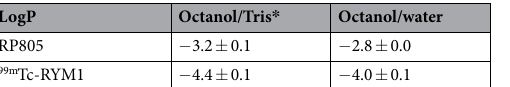
Table 2. LogP values of 99m Tc-RYM1 and RP805. The data represent the mean ± SD of 2 independent experiments, each performed with triplicate determinations. * pH 7.4.